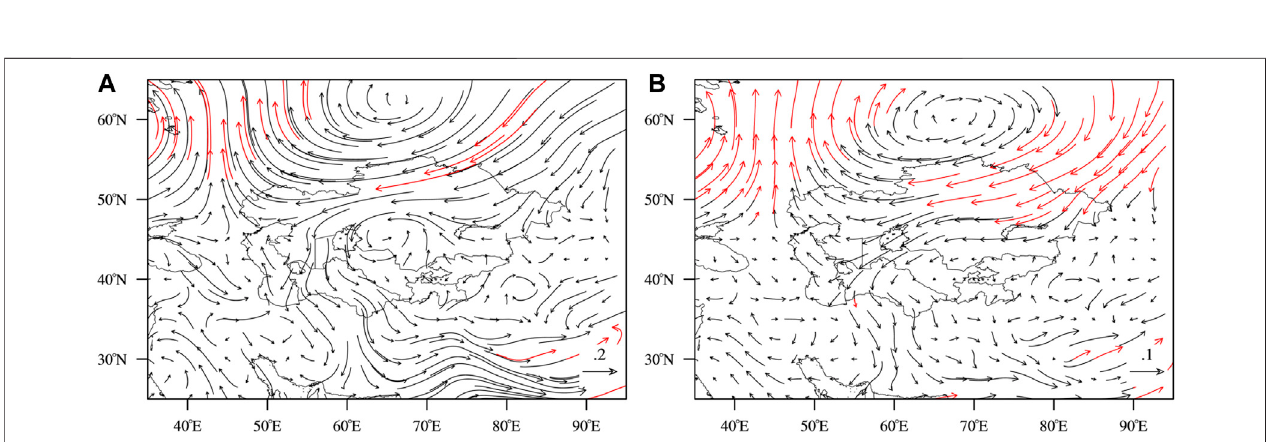
fi eld in (A,C) and dotted area in (B,D) are the areas that passed the 90% con fi dence level student ’ s t-test.